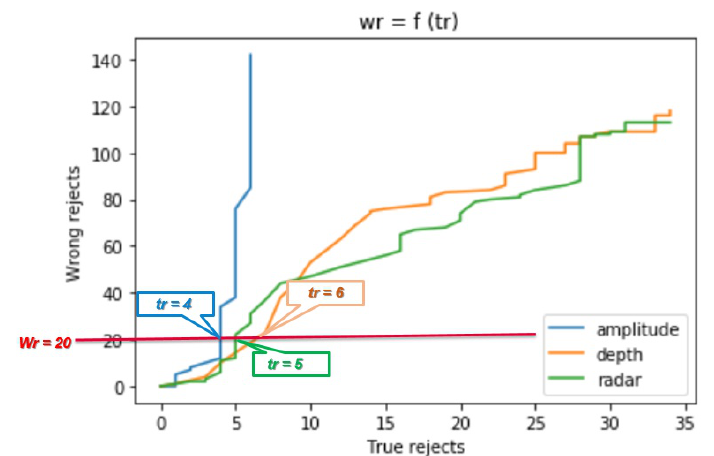
Figure 9. Number of wrongly rejected data points regarding the number of correctly rejected data points for the three classifiers corresponding to the three considered